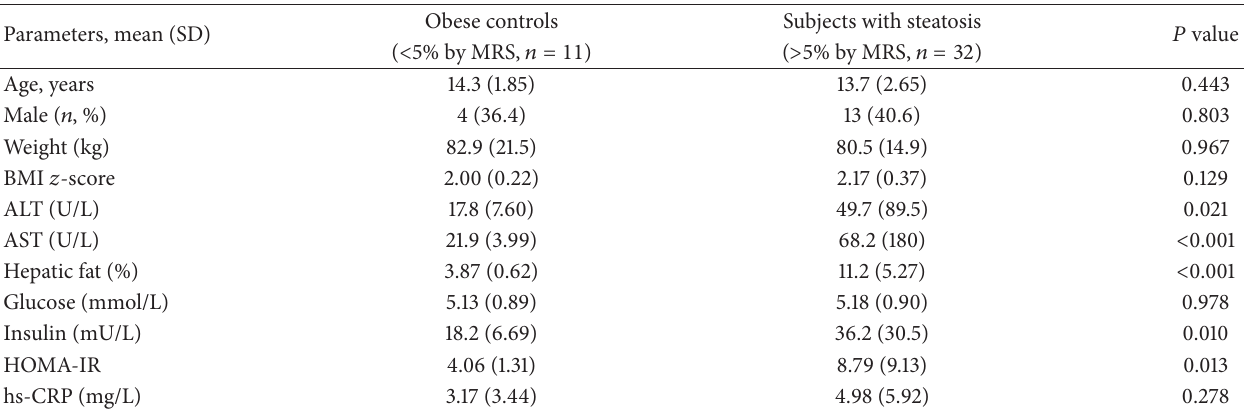
Table 1: Anthropometrics and laboratory parameters of the 32 adolescents with hepatic steatosis and the 11 obese controls at fasting state: study cohort 1.